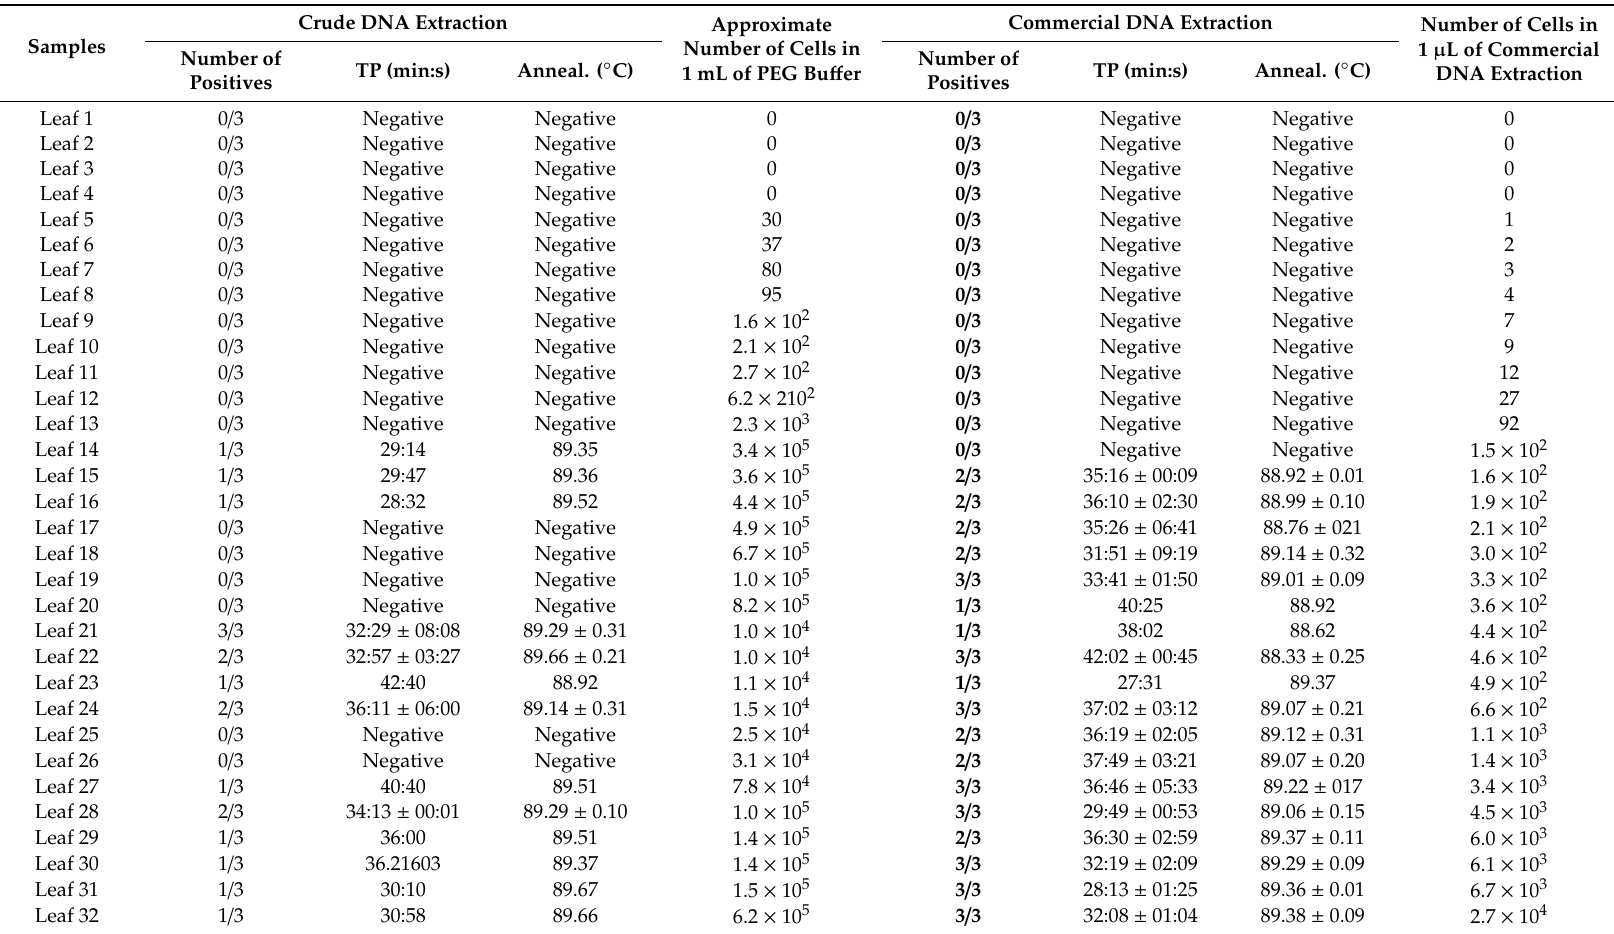
Table 5. Comparison between the crude extraction and commercial DNA extraction using asymptomatic apple leaf samples for both types of DNA extraction (crude extraction and commercial extraction). Approximate number of cells in the crude DNA extraction and in the final elution of the commercial DNA extraction was calculated in three biological replicates with the qPCR assay. The number of positives with each extraction are also reported Tp = time to positive, Anneal. = annealing